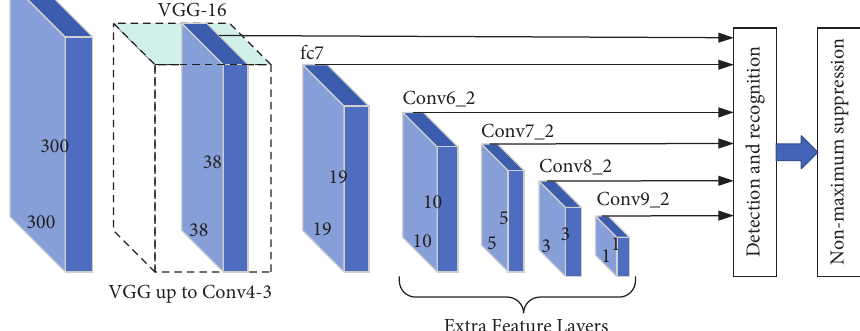
Figure 1: SSD algorithm structure.